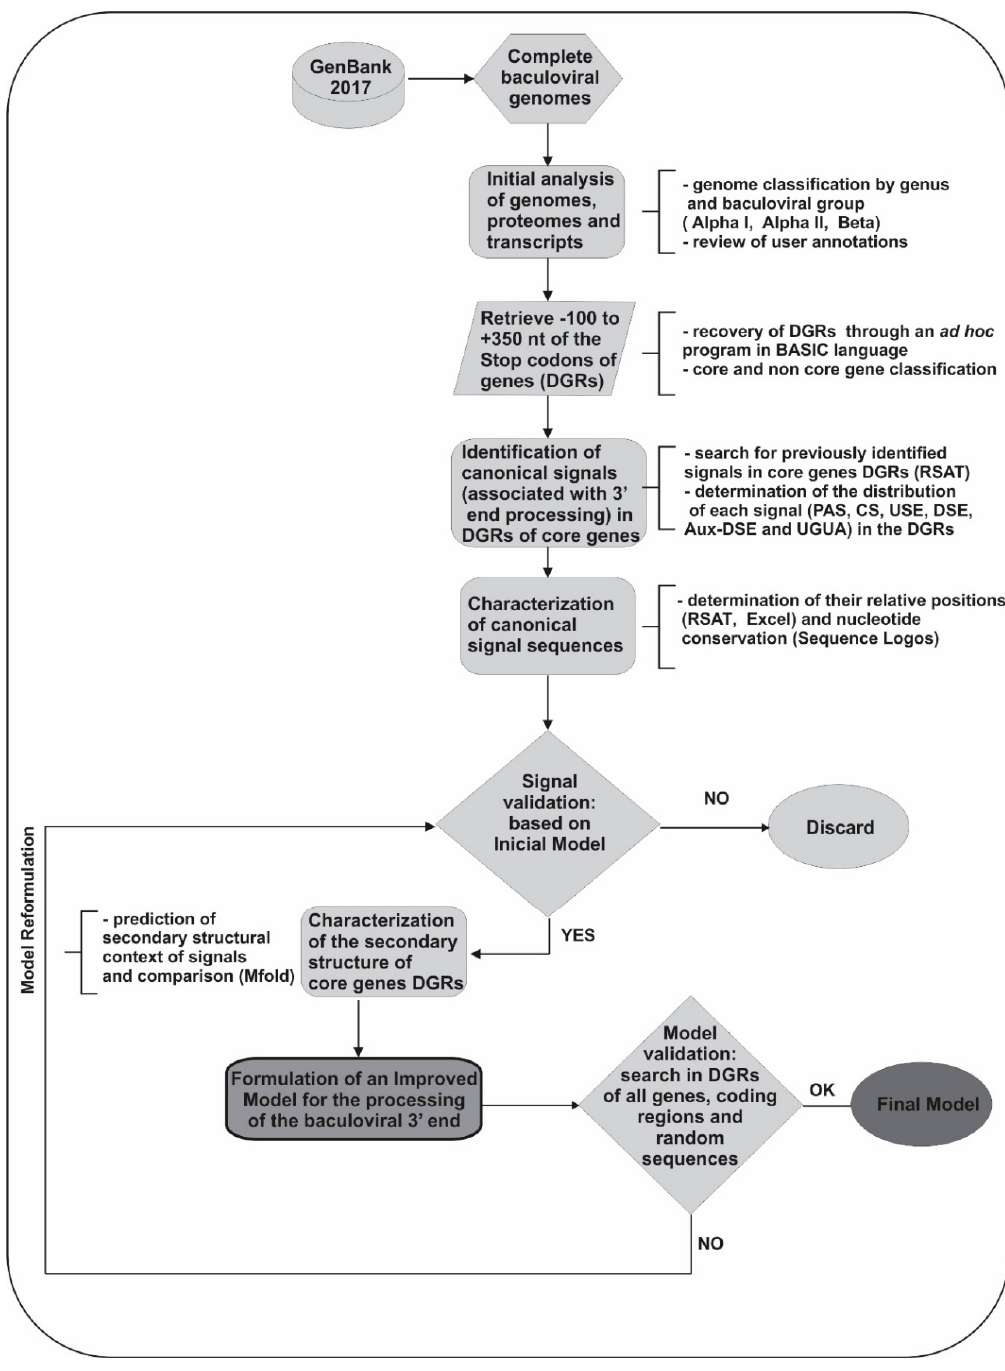
Figure 4. Workflow summary. A workflow diagram summarizing the bioinformatic analysis performed on downstream gene regions (DGRs: − 100 to +350 relative to stop codon) of all predicted baculoviral genes is shown. 180 complete genomes (GenBank) were used, of which 53 were alphabaculoviruses Group I, 90 alphabaculoviruses Group II and 37 betabaculoviruses. The programs used in each step are indicated in parentheses. Alpha I: alphabaculoviruses Group I; Alpha II: alphabaculoviruses Group II; Beta: betabaculoviruses. PAS: Polyadenylation signal; USE: Upstream sequence element; DSE: Downstream sequence element; CS: Cleavage site: Aux-DSE: Auxiliary downstream sequence element; UGUA: motif that is eventually found upstream to the PAS and transcription end